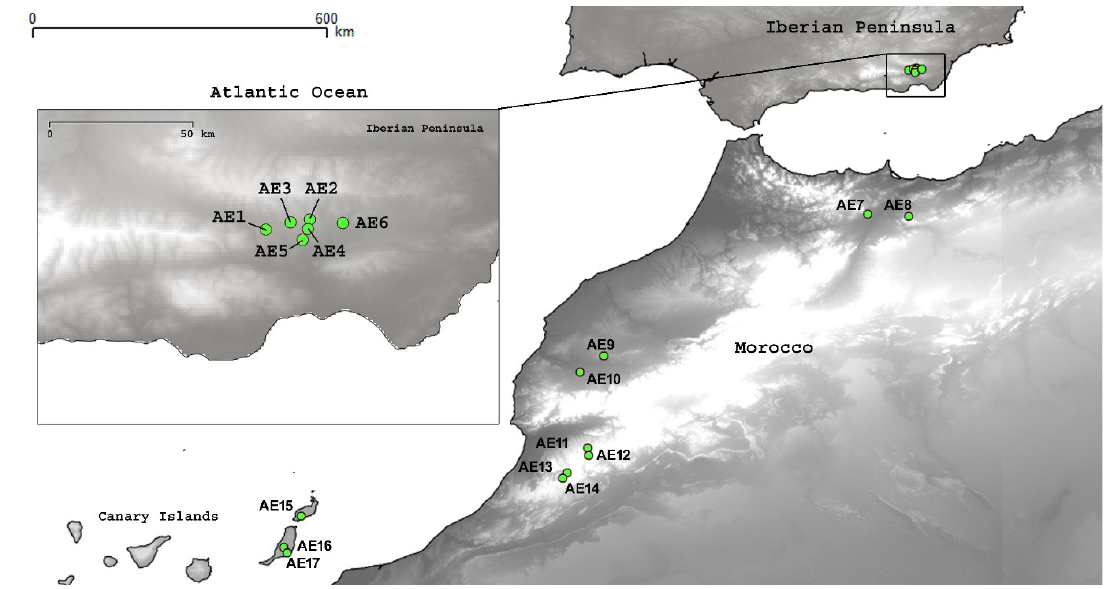
Figure 1. Location of the populations of Astragalus edulis studied.